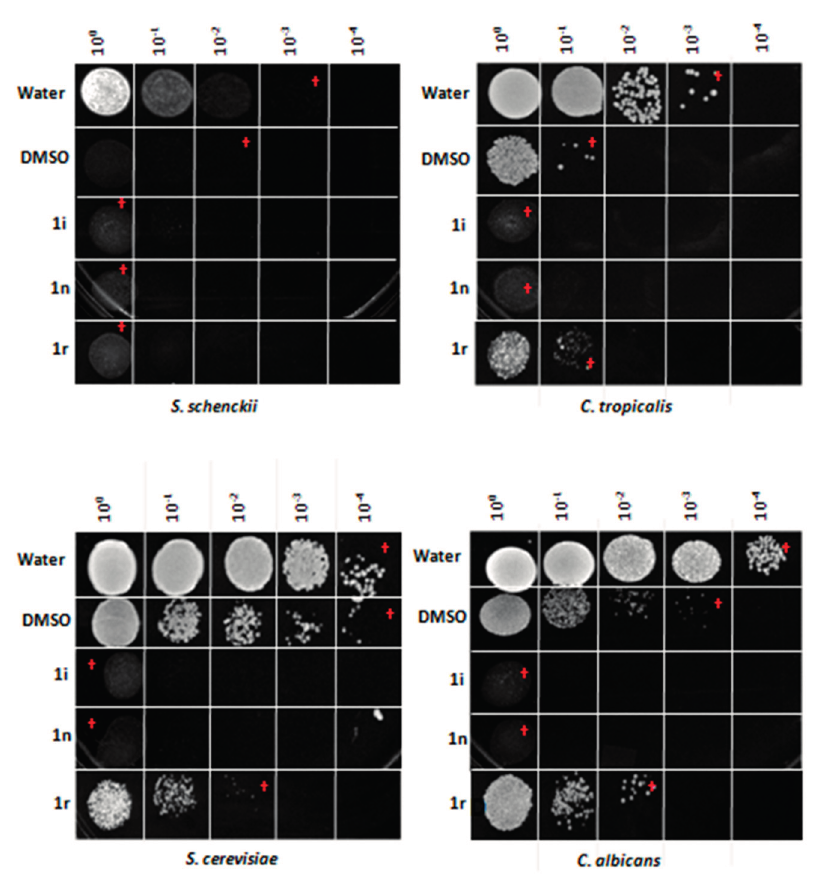
Figure 3. Fungicide Effect of 1i , 1n , and 1r chromone-tetrazoles in liquid